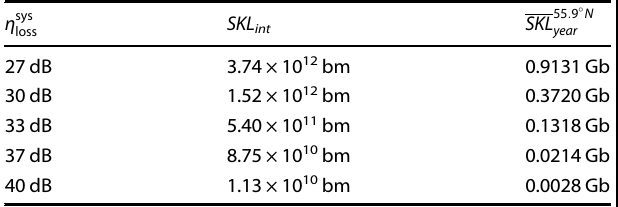
Table 2. Expected annual SKL for different η sys correspond to the area under each SKL vs d min curve in Fig. 5 with units of bit-metres (bm).